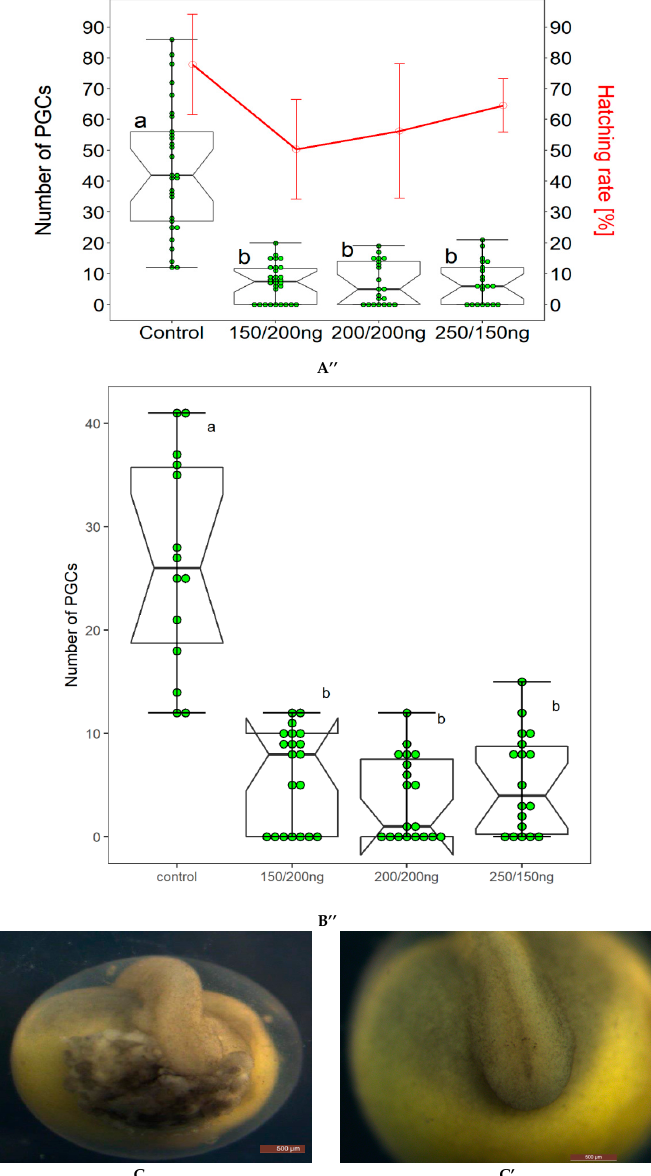
Figure 1. Number of FITC-labeled PGCs reduced from neurula stage to tail bud stage after embryos were injected with RNPs (sgRNAs + Cas9 protein). ( A ) Control group and RNPs injected group with FITC-dextran to label the PGCs at tail bud stage [40], respectively. Embryos injected with RNPs ( A’ ) are lacking the FITC-labeled PGCs around surround the region where tail develops; however, in control group ( A ) FITC-labeled PGCs can be easily seen. ( A” ): Di ff erent concentrations of sgRNAs and Cas9 protein were used to find optimal concentrations; however, no significant di ff erence of sgRNAs / Cas9 concentrations was found on FITC-labeled PGCs (box graphs). Hatching rates were also found to be insignificant (line graph). ( B , B’ ): In fluorescent image, many FITC-labeled PGCs can be seen in gonadal region (under a white broken line) in the control group ( B ); however on the contrary no FITC-labeled PGCs can be seen at the same region when injected with RNPs complex (B’; under white broken line). Number of FITC-labeled PGCs were observed by opening the body cavity of larvae, FITC-labeled PGCs were found to be in lower number when di ff erent concentrations of sgRNAs / Cas9 were used; while in the control group, FITC-labeled PGCs were found in a higher number ( B” ). ( C ) Malformed embryo at 4 dpf after the injection of RNPs (in one batch of eggs from one female) and the non-injected control group ( C’ ). The boxes with di ff erent letter show the significant di ff erence ( p <